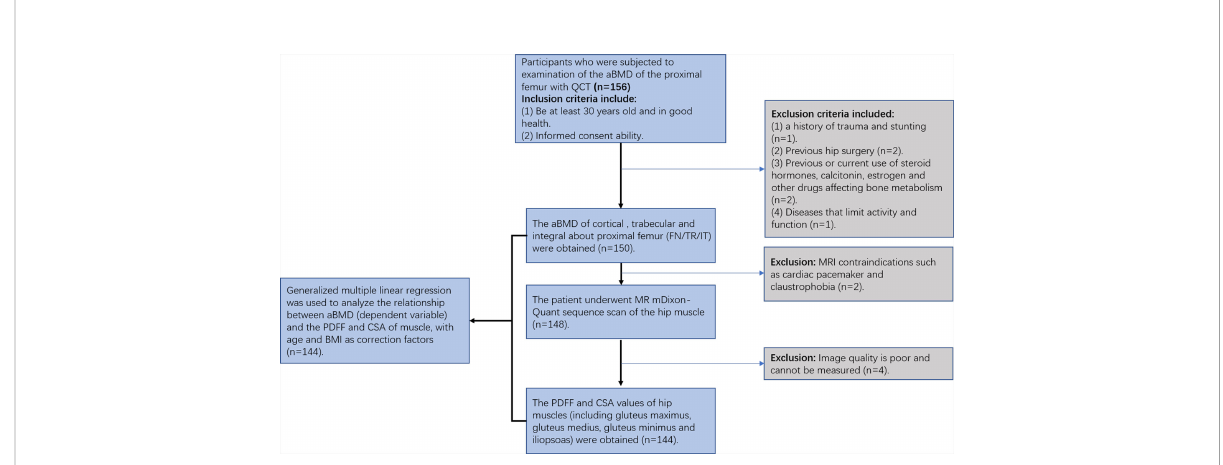
FIGURE 1 Flow chart of the patient population included in the present